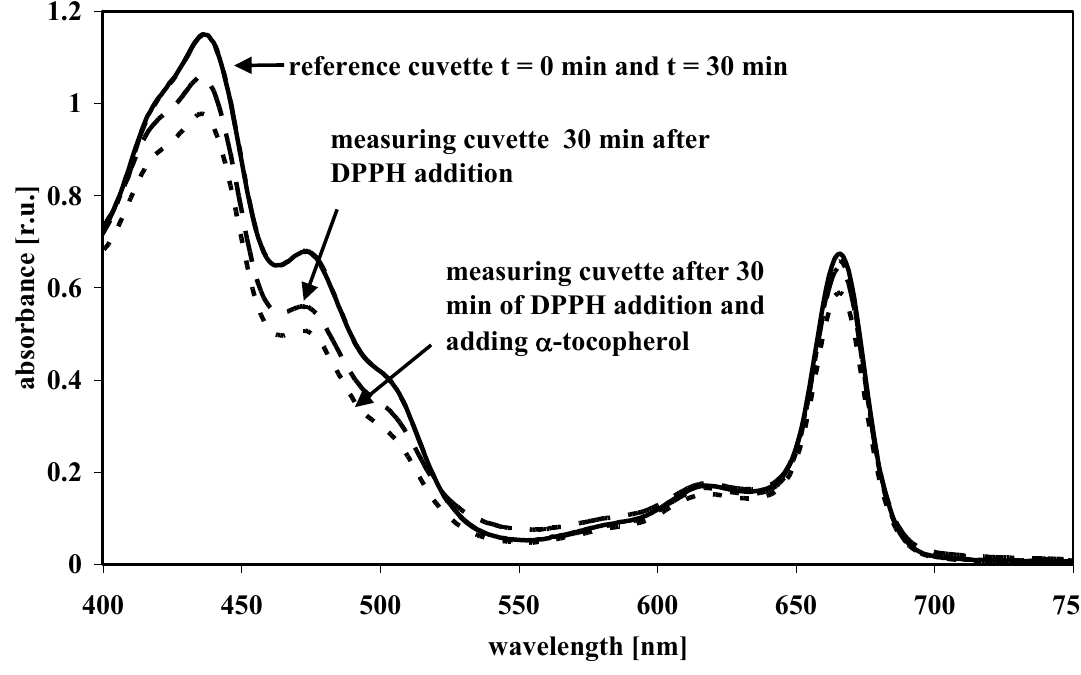
Figure 1. Wavelength scans of Synechocystis sp. PCC6803. Both measuring and reference cuvette